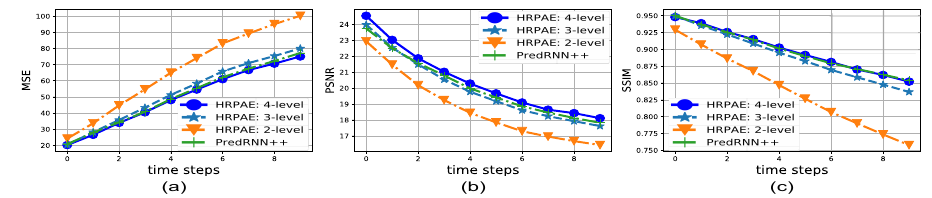
Figure 4. Frame-wise performances over the testing MMNIST dataset. ( a – c ) represent the averaged MSE, PSNR and SSIM evaluation metrics over the next 10 predicted frames, respectively.